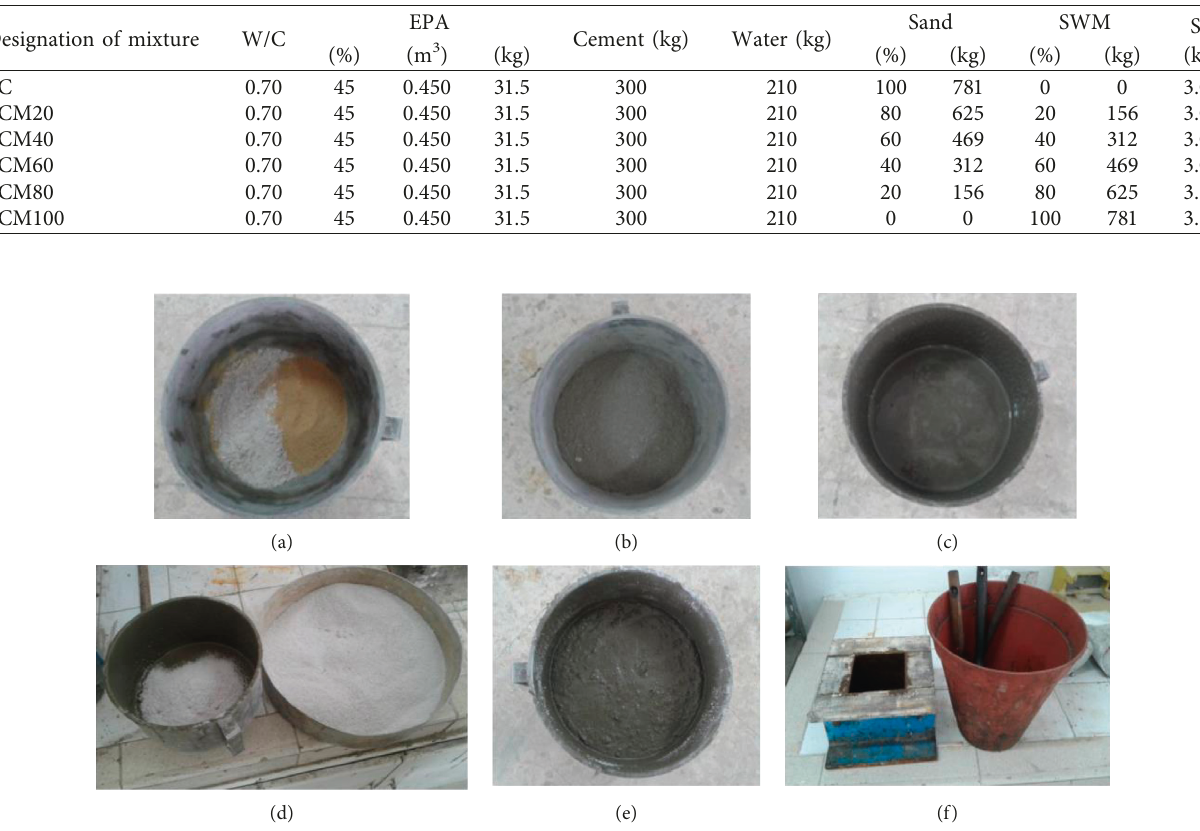
Table 5: Mixture composition.